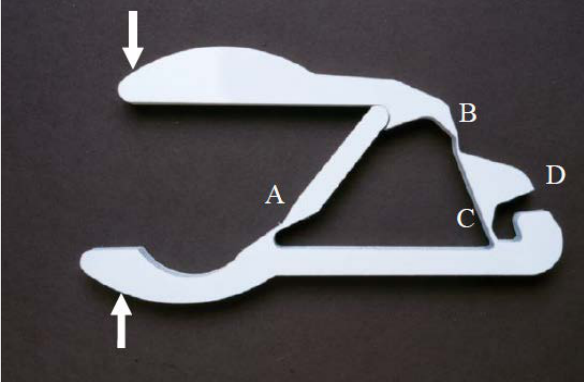
Figure 1. A compliant gripper. Courtesy of the Compliant Mecha- nisms Research Group at Brigham Young